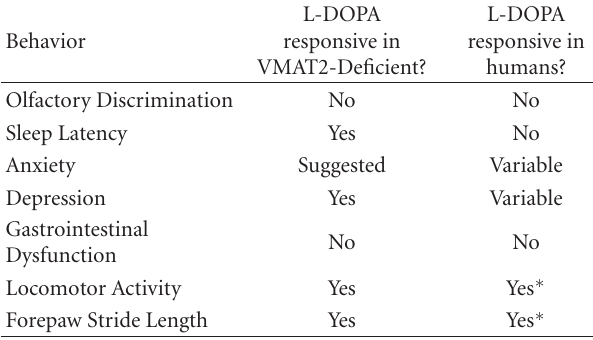
Table 1: Summary of L-DOPA responsive Parkinsonian